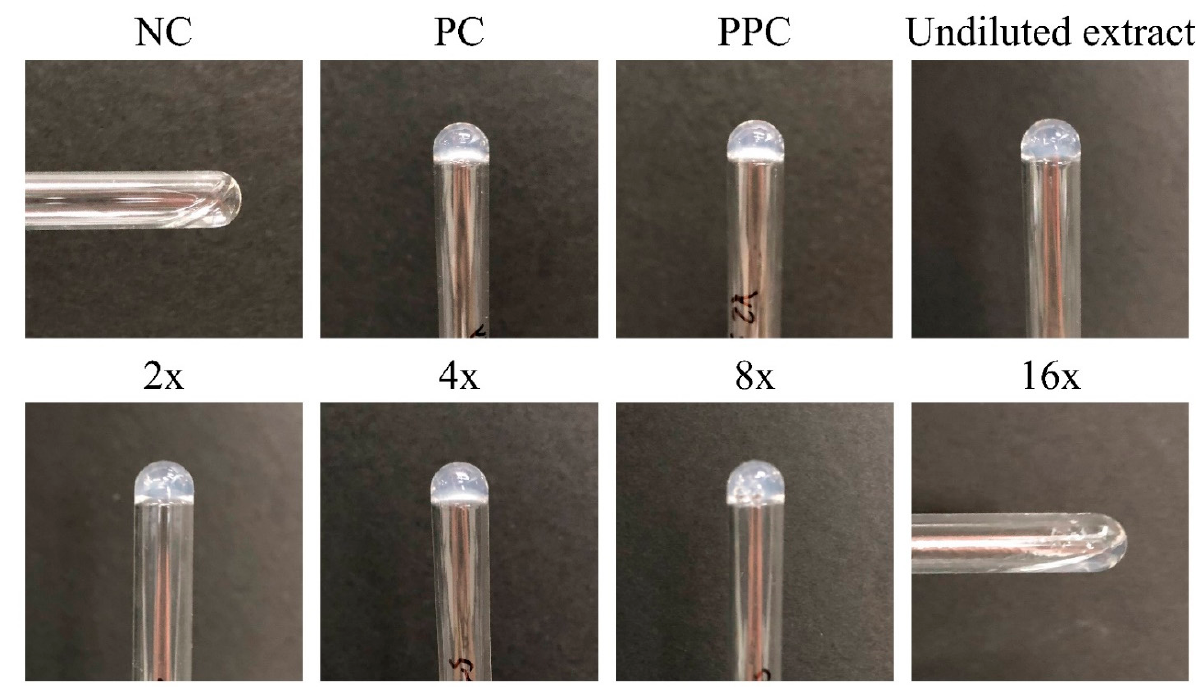
Figure 5. Bacterial endotoxin results of sterilized hydrogel macrospheres (NC: negative control; PC: positive control; PPC: positive product control; 2×, 4×, 8×, and 16× indicate extracts diluted with pyrogen-free water).